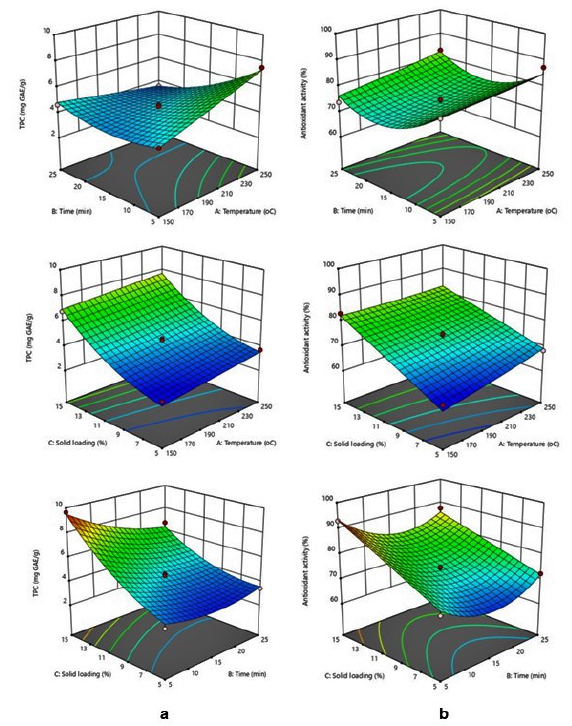
Fig. 2. Three-dimensional response surface of TPC (a) and antioxidant activity (b) from Piper betle L. leaves extracted by PHW as a function of temperature, time, and solid loading.